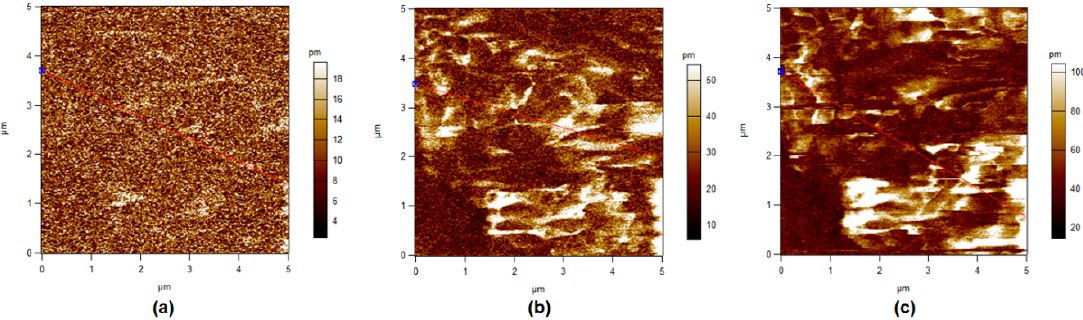
Figure 8. Piezoresponse force microscope (PFM) amplitude retrace of PVDF at different applied voltages. ( a ) 1 V, ( b ) 5 V, and ( c ) 10 V.